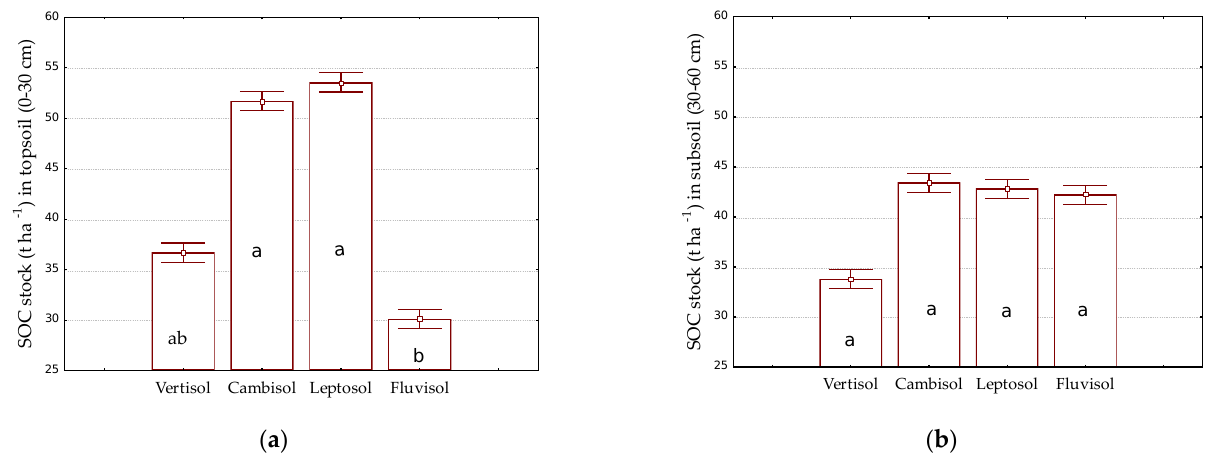
Figure 7. Soil organic carbon (SOC) stocks: ( a ) topsoil, 0–30 cm (N = 56), and ( b ) subsoil, 30–60 cm (N = 56). Significant differences among soil groups are labeled with different letters (Duncan’s range test, p < 0.05).